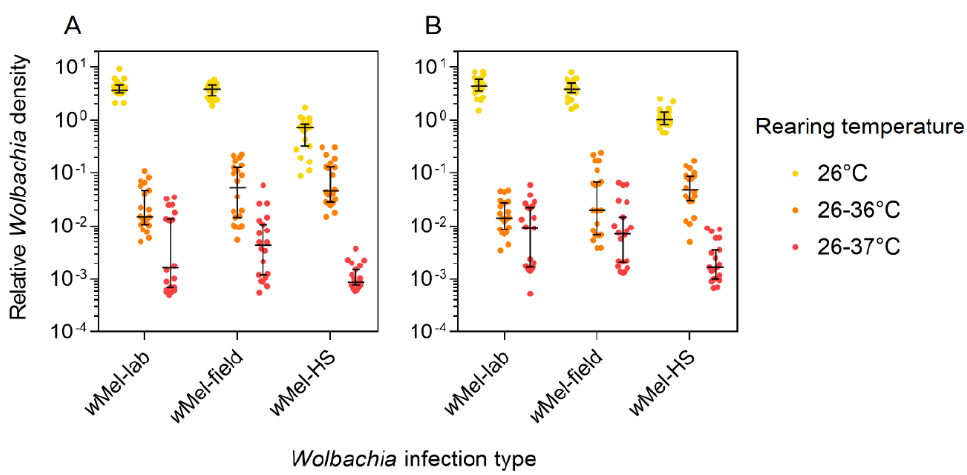
Figure 4. Relative Wolbachia density of laboratory and field-derived w Mel-infections. Females ( A ) and males ( B ) from the w Mel-lab, w Mel-field, and w Mel-HS (following eight generations of selection) lines were reared under three temperature conditions. Black bars indicate median densities with 95% confidence